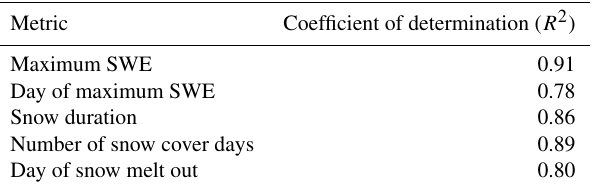
Table 4. Spatial correlations ( R 2 ) between observations at SNO- TEL sites and SnowClim simulations for various snow metrics over